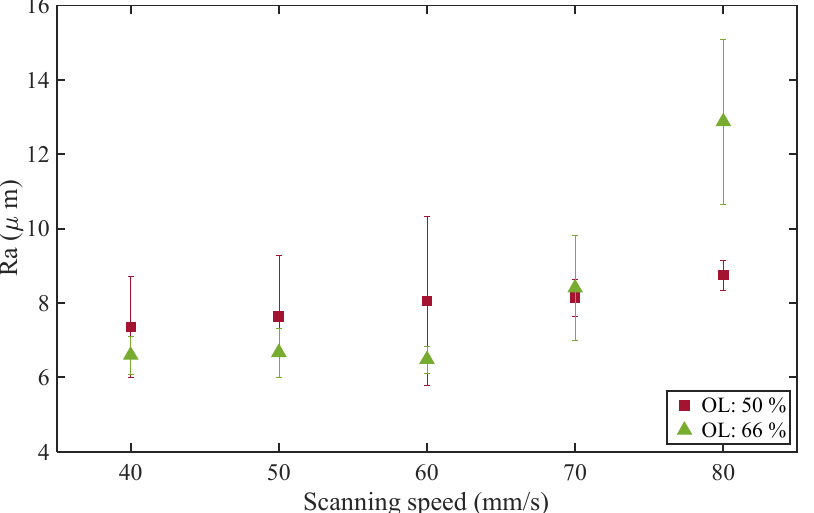
Figure 7. Surface roughness of WBS at different swing overlap ratios and scanning speeds.